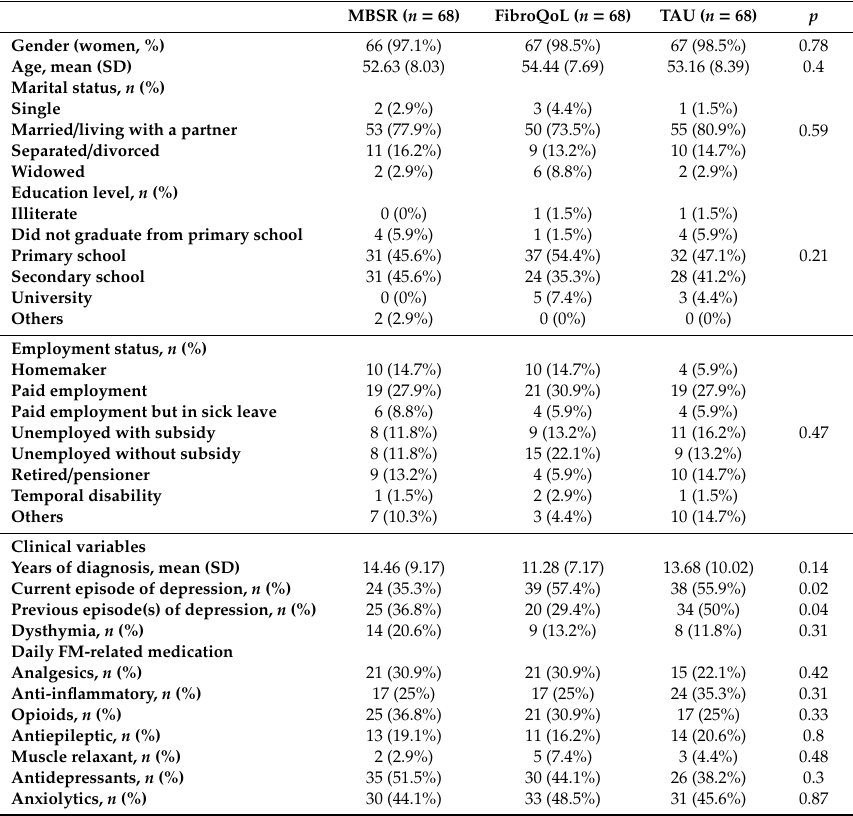
Table 2. Baseline characteristics of patients with Fibromyalgia (FM) by treatment group.